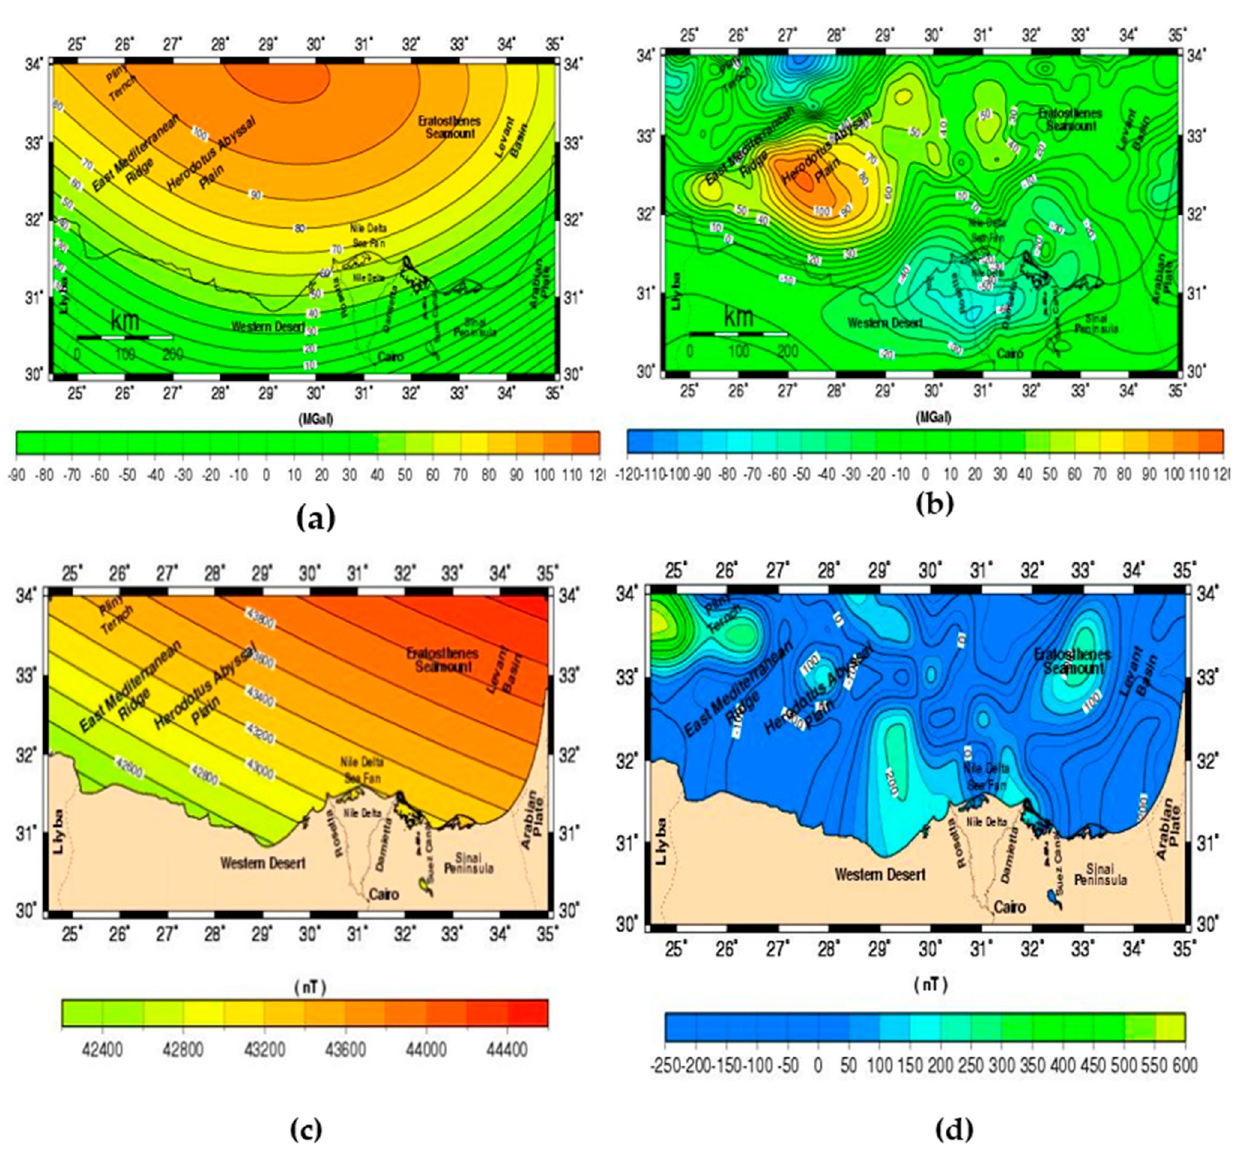
Figure 3. ( a , b ) Regional and residual gravity maps; ( c , d ) regional and residual magnetic maps of the area investigated.